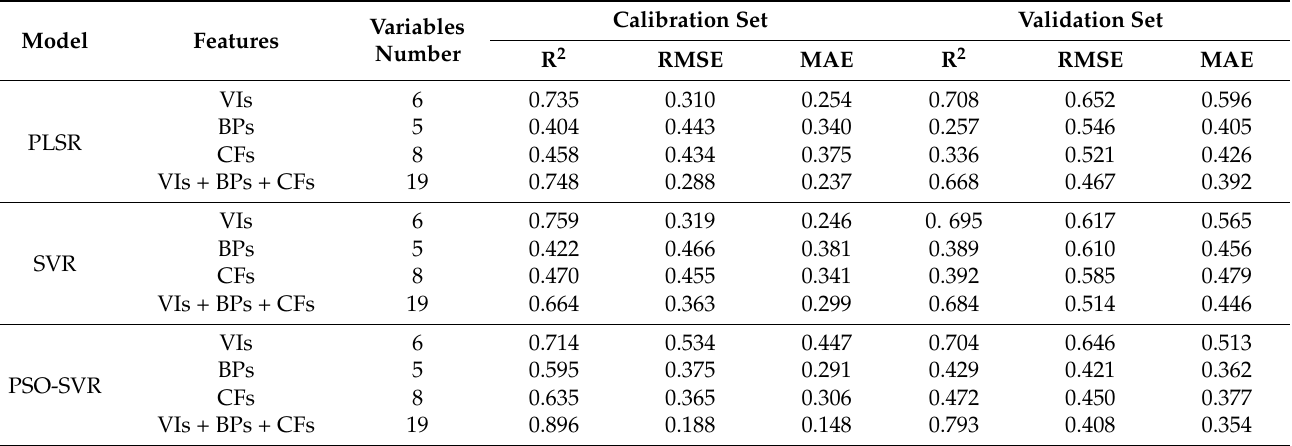
Table 3. The estimated results for wheat LNC based on different features.